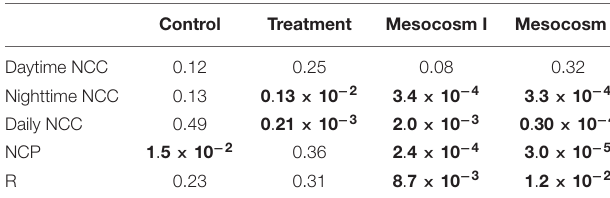
TABLE 4 | Student’s t -test results ( p -value) comparing the difference in daytime, nighttime and daily net community calcification (NCC), net community production (NCP), and respiration (R) between the replicate mesocosms during the control and treatment periods, and the difference between the control and treatment periods in the replicate